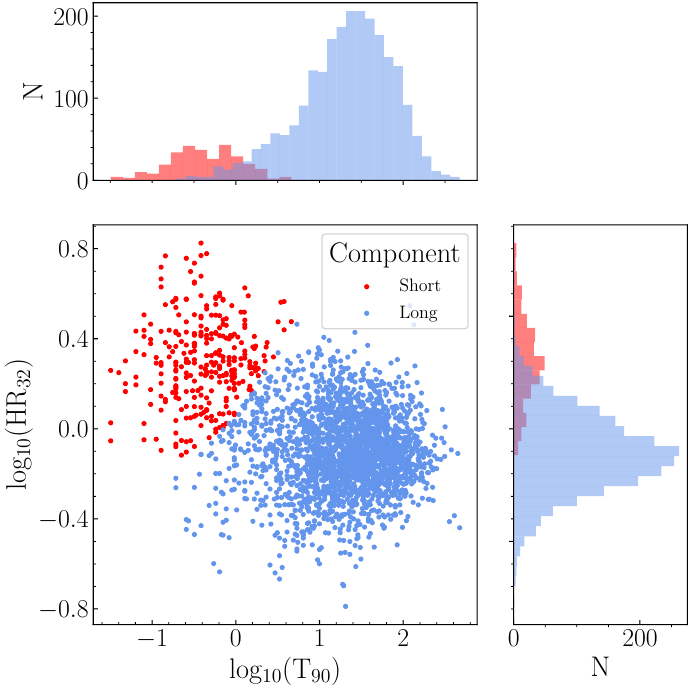
Figure 6. The results of clustCombi applied to the components identified by MCLUST in the duration- hardness plane for Fermi /GBM.